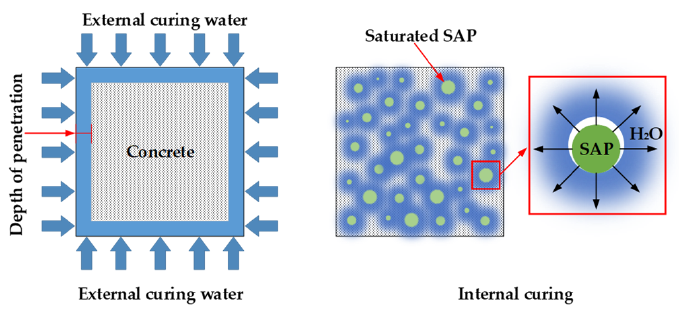
Figure 1. Different mechanisms between external and internal curing methods. Figure 1. Di ff erent mechanisms between external and internal curing